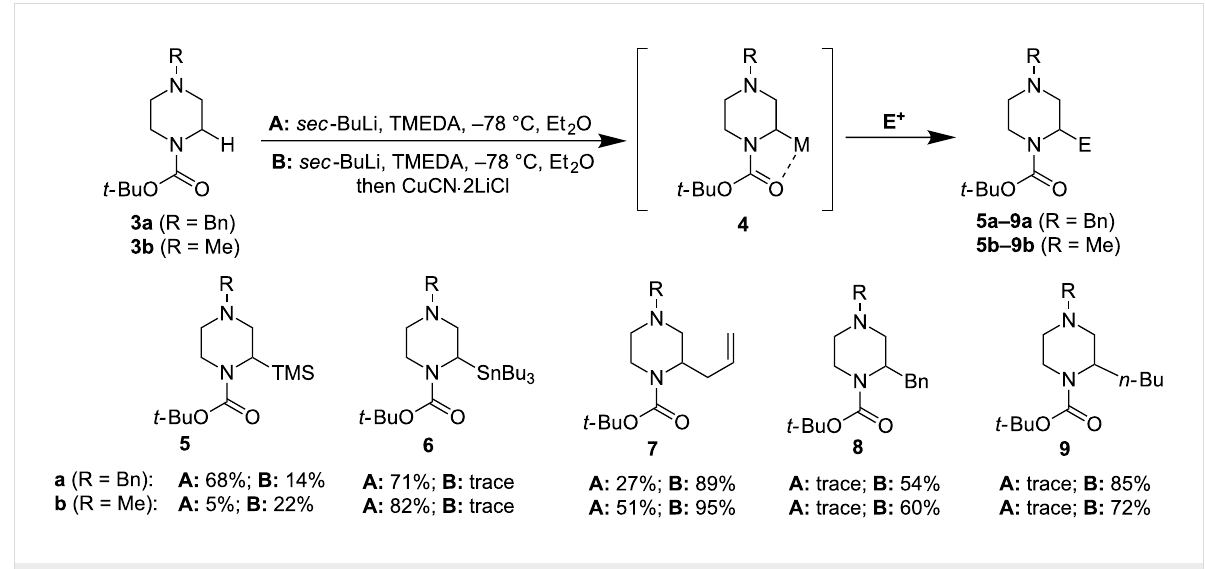
Figure 3: The first α -lithiation of N -Boc-protected piperazines by van Maarseveen et al. in 2005